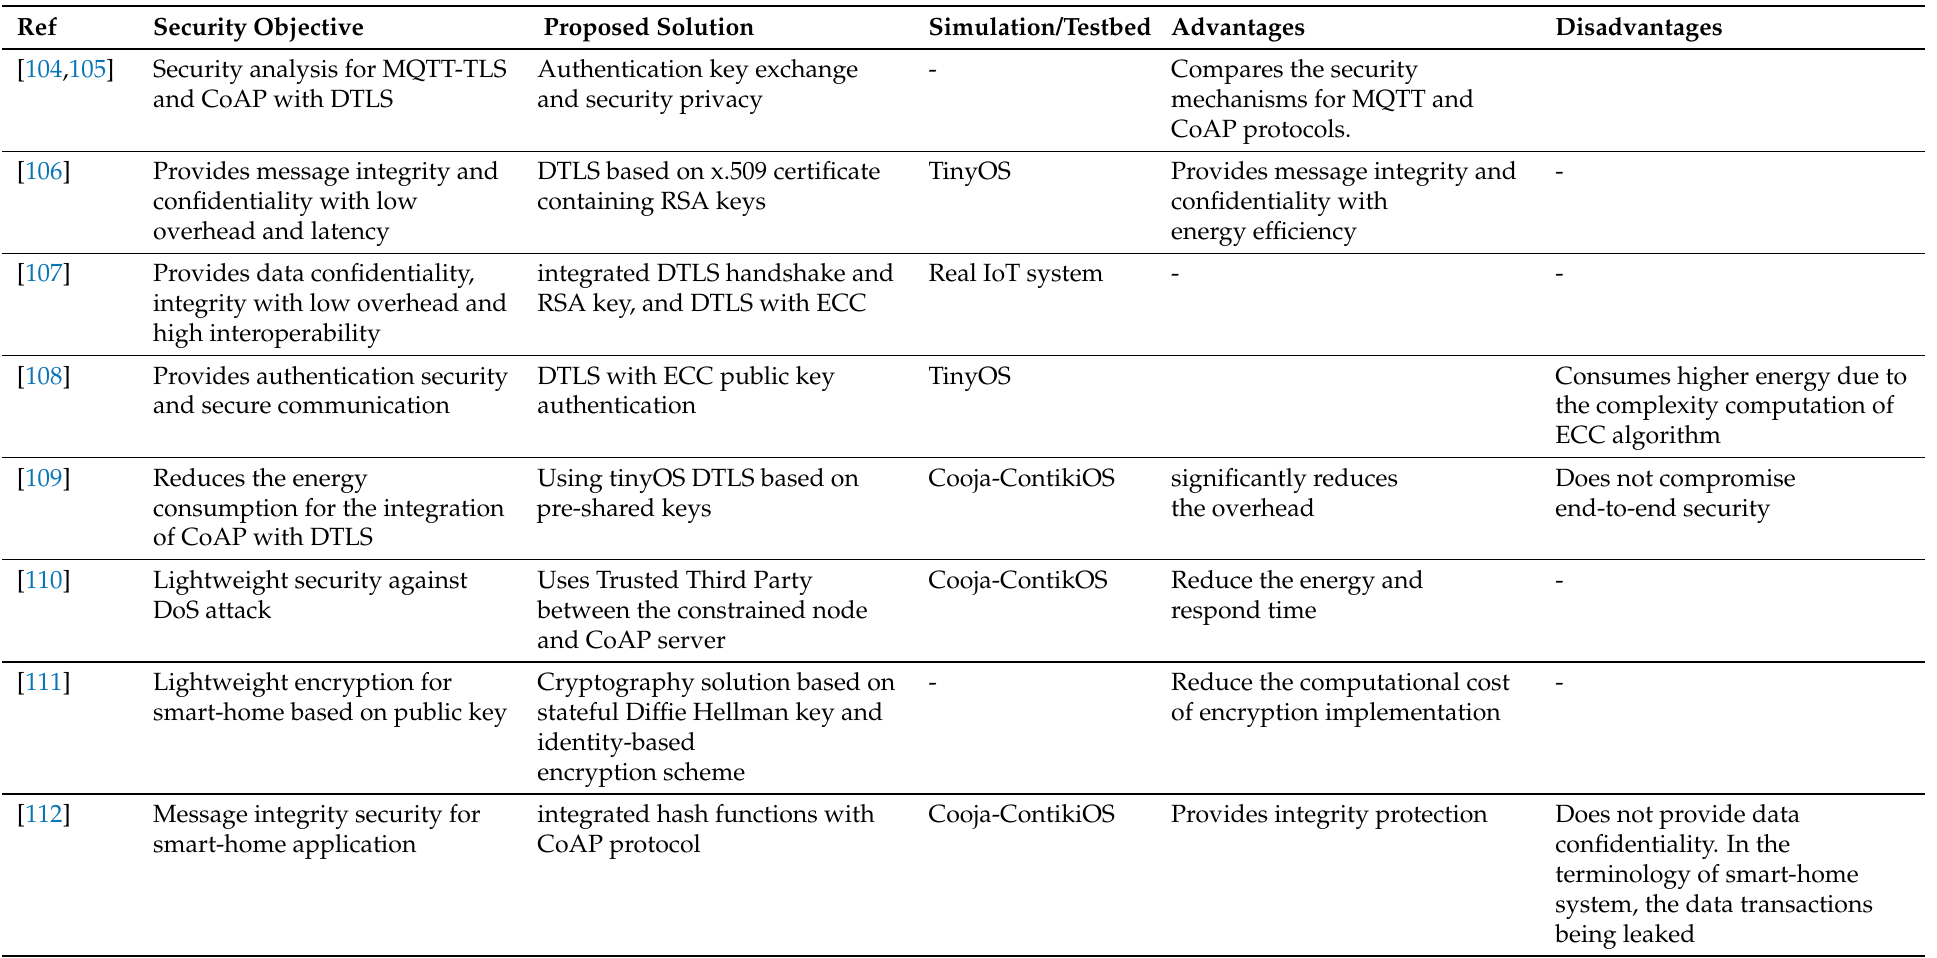
Table 4. Classification of IoT security solution for transport and